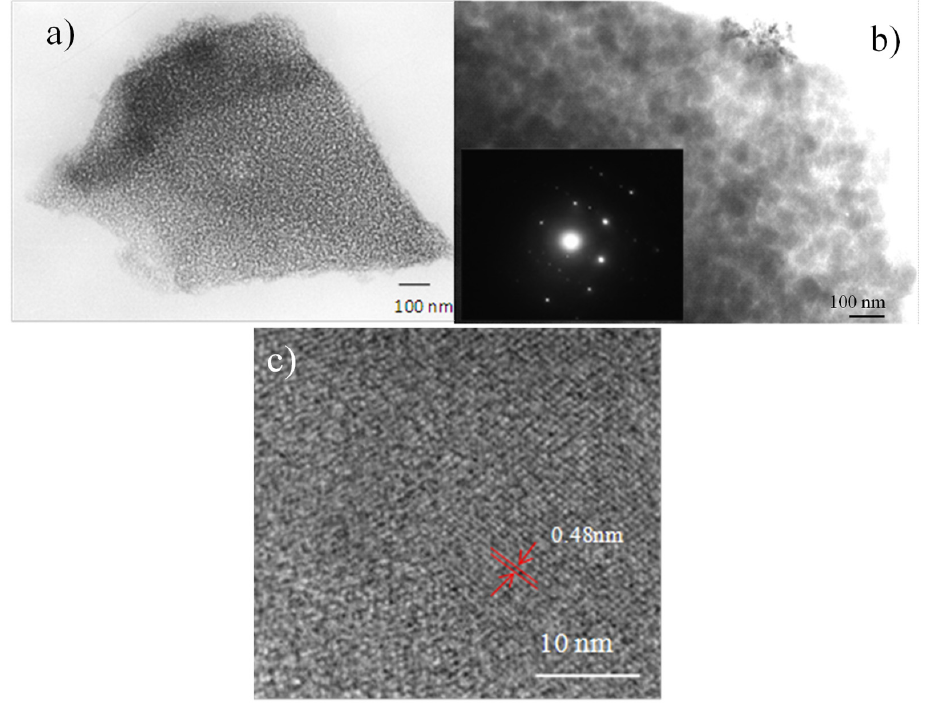
Figure 3. Transmission electron microscopy images and electron diffraction patterns for mesoporous thin films calcined at ( a ) 350 °C, 12 h and ( b ) 700 °C, 15 min with FTT image as inset, and ( c ) TEM image treated with Gwyddion program to index the crystal structure.